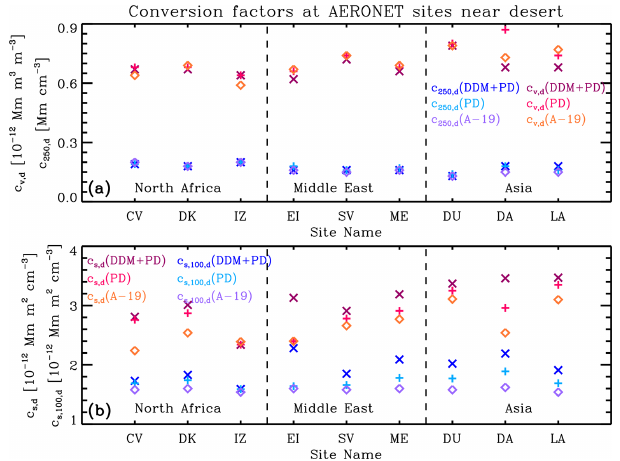
Figure 4. Intercomparison of dust-related conversion factors at nine sites (as shown in Table 2) near the deserts; (a) c v , d and c 250 , d as well as (b) c s , d and c s , 100 , d are calculated with the dust (both PD+DDM and PD) data selection scheme (based on the particle lin- ear depolarization ratio) in this study with those derived with the constraints of the Ångström exponent for the 440–870nm wave- length range AE 440–870 < 0.3 and aerosol optical depth at 532nm AOD 532 > 0.1 given by Ansmann et al. (2019b) (denoted as A-19).